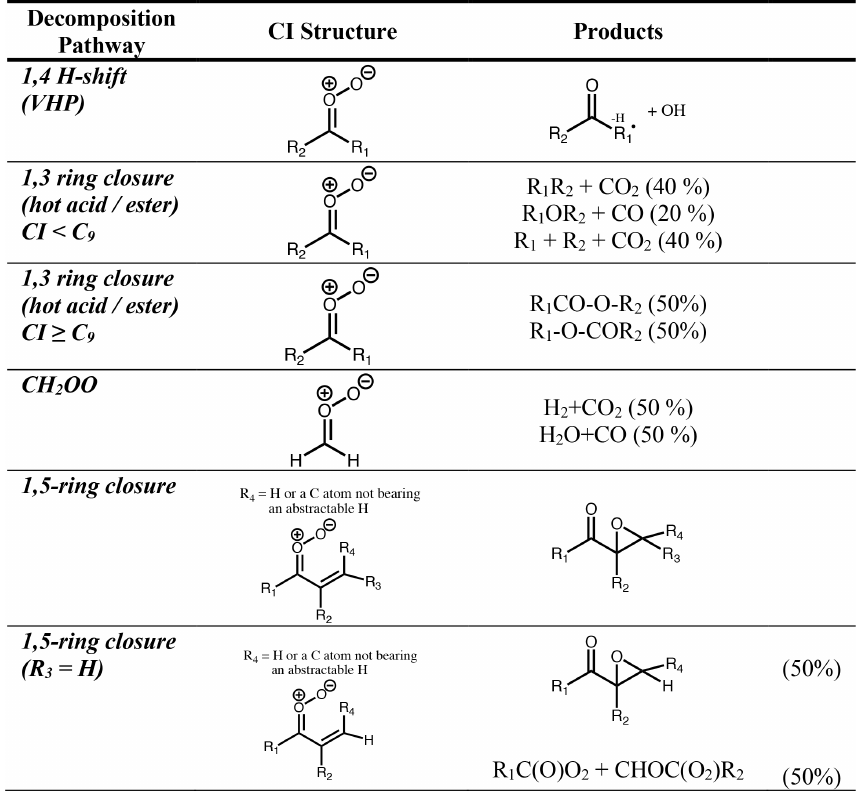
Table 3. Bimolecular reaction rates with RCOOH, SO 2 , NO 2 and inorganic acids applied to the four SCI structures. Rates are IUPAC recommendations (Cox et al., 2020) unless otherwise stated. Bimolecular reaction rates with water are taken from Vereecken et al. (2017); see main